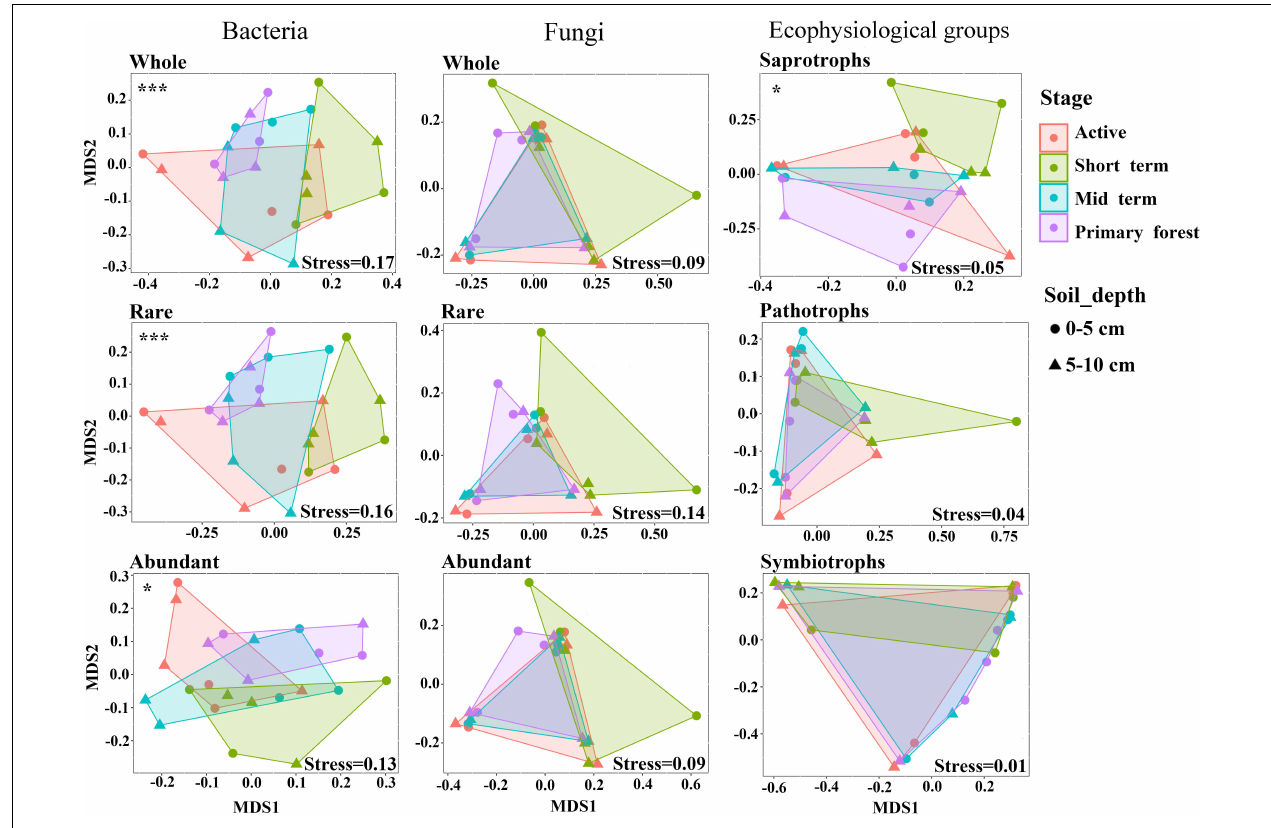
FIGURE 1 | Non-metric multidimensional scaling (NMDS) ordination based on weighted Bray–Curtis dissimilarities of bacterial and fungal communities and fungal ecophysiological groups. Significant differences across successional stages were marked as * p < 0.05 and *** p < 0.001. No significant differences were detected across soil